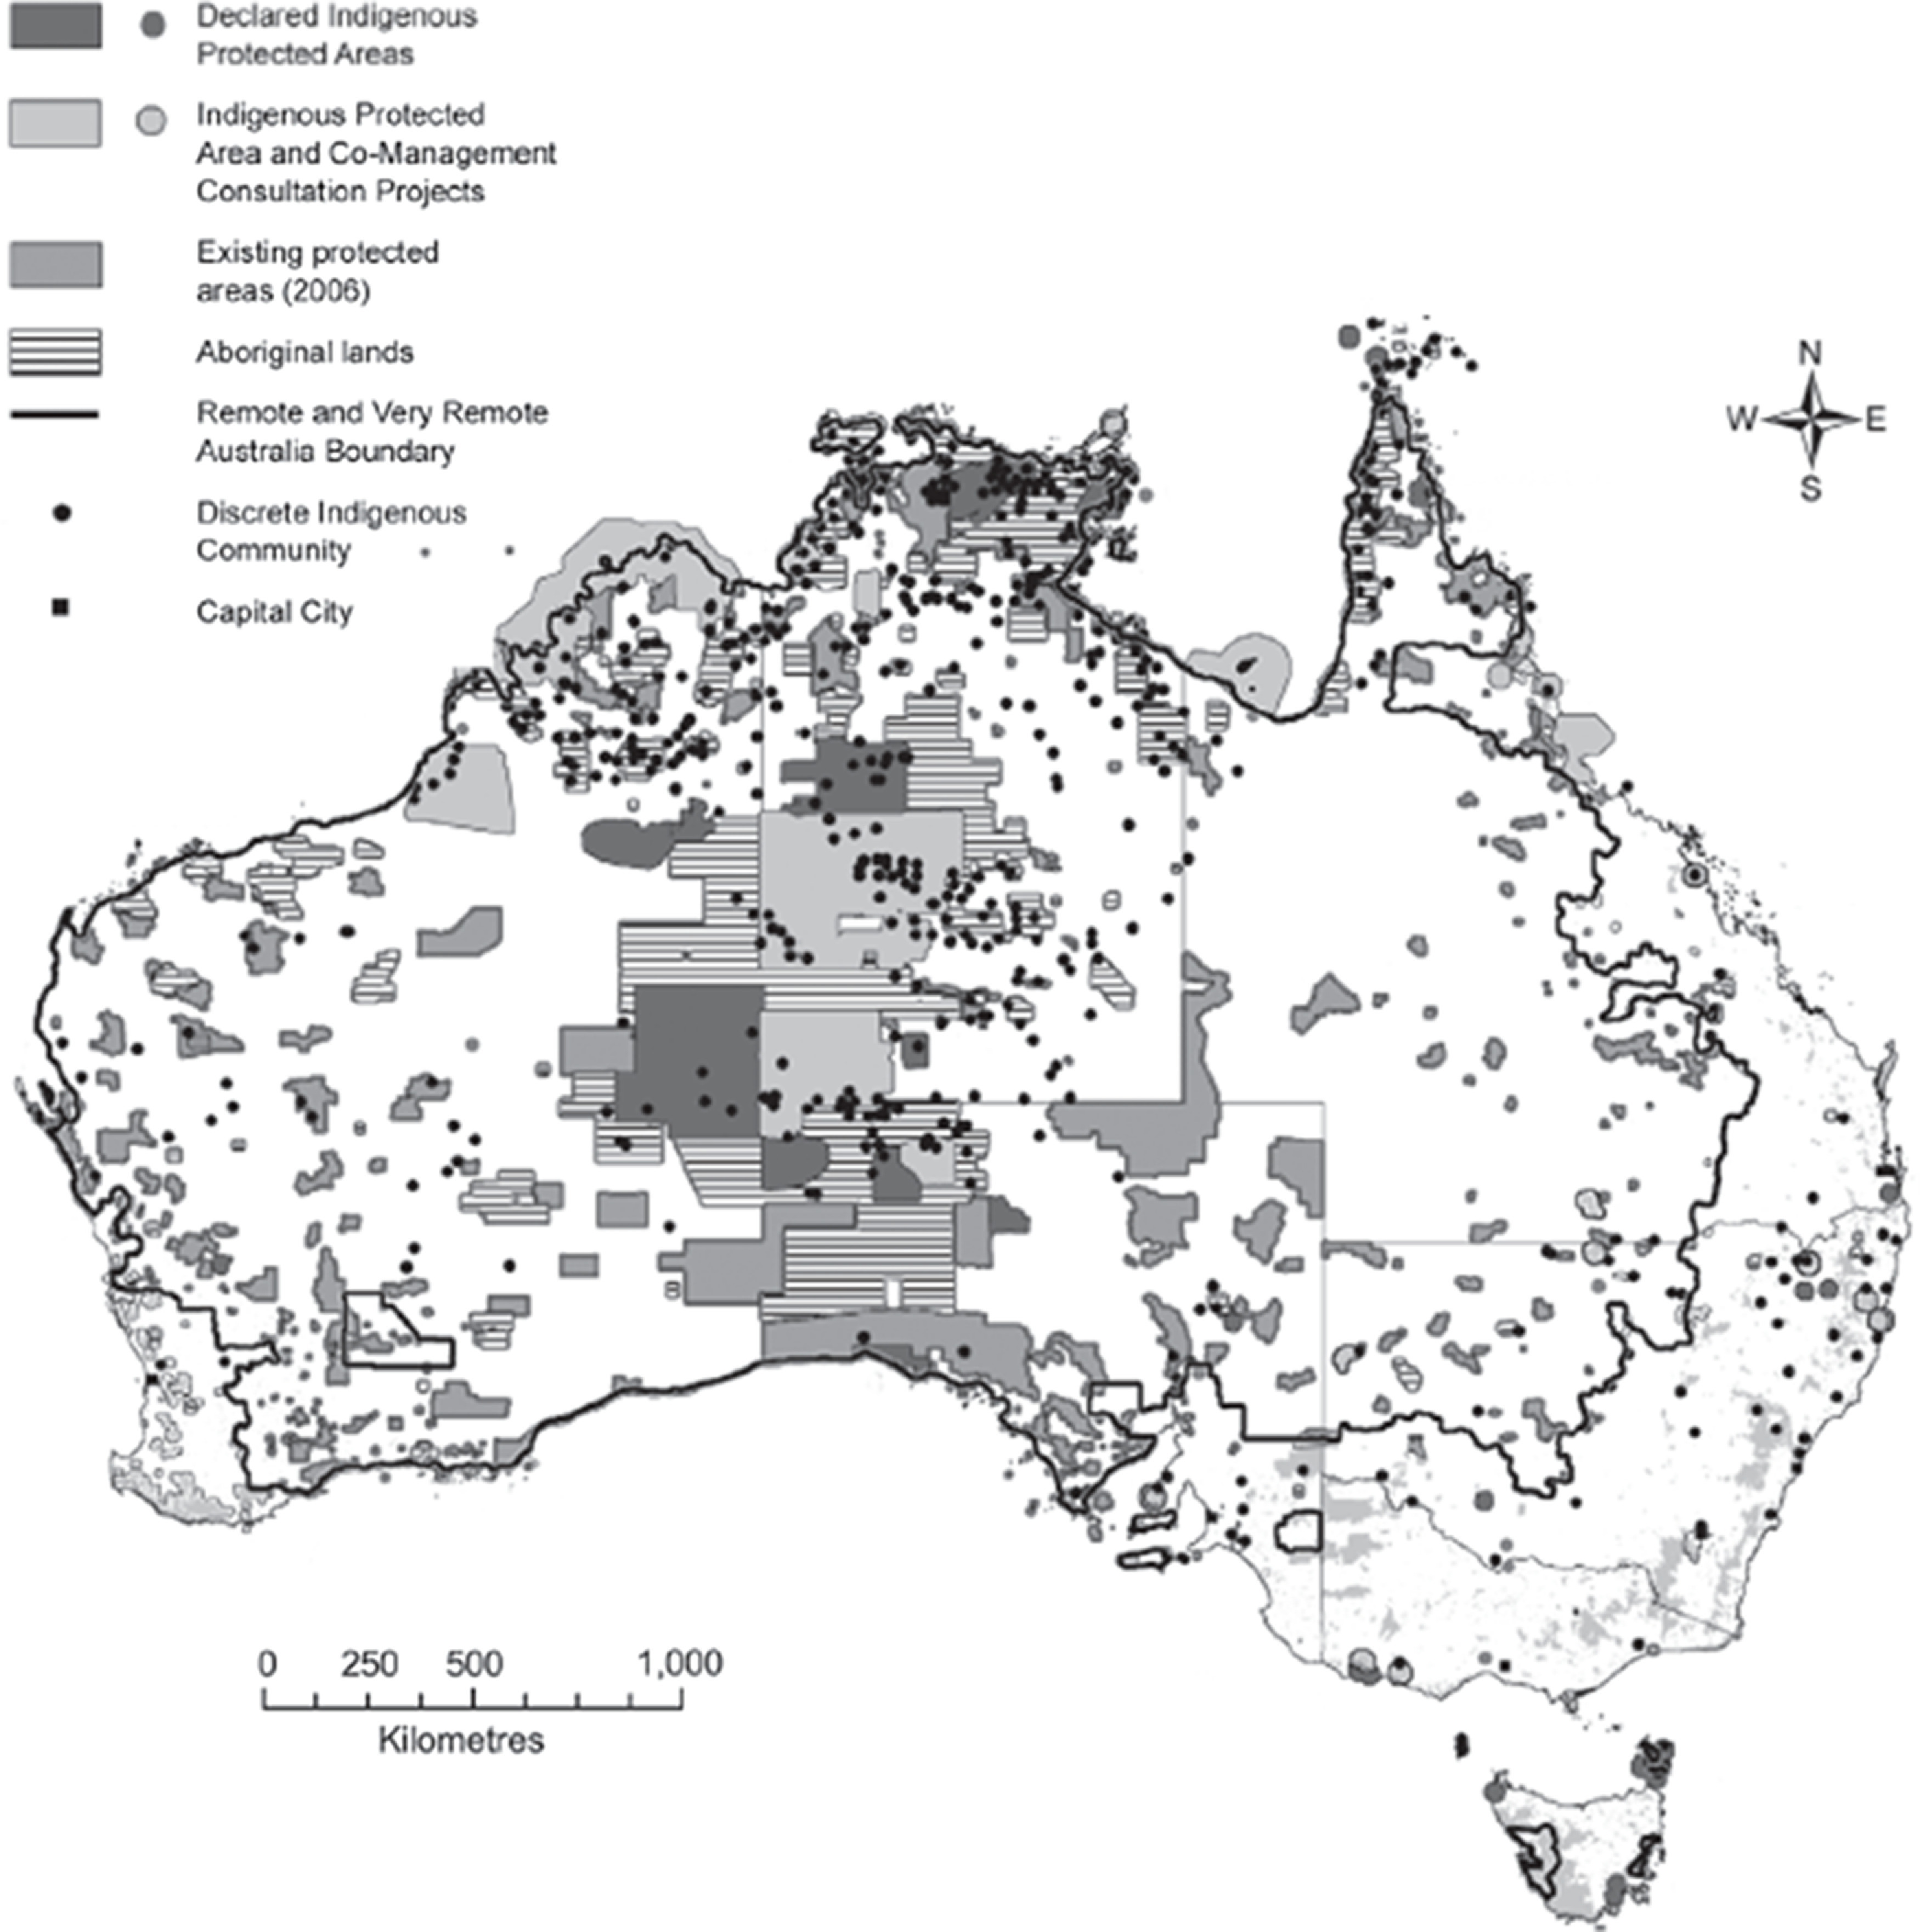
Indigenous protected areas and discrete Indigenous communities (from Altman & Fogarty, 2010).